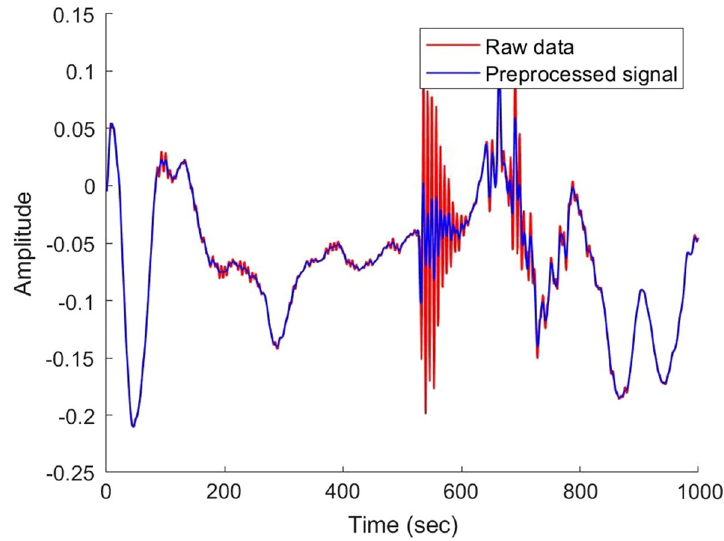
Fig. 7 Effect of the Savitzky–Golay filter on lung sounds recording. The signal is very noisy; over the segment of the time period 530–580 s, the Savitzky–Golay filter eliminates the sharp spurious